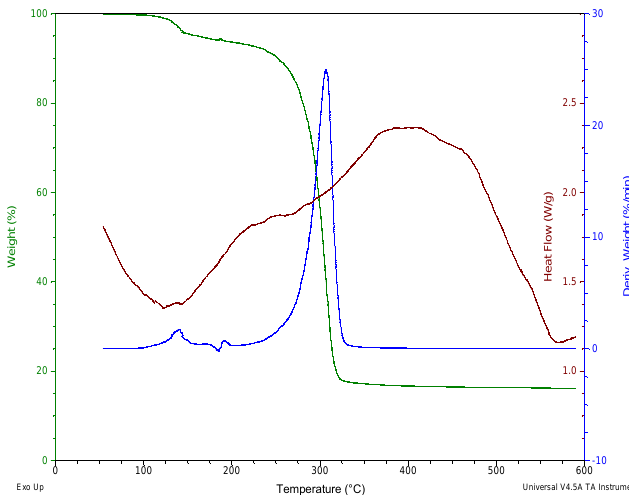
Figure 16. TG/DTG and DSC curves of diphenyltin(IV) N -methyl- N -phenyl dithiocarbamate obtained in N 2 (75 mL/min at heating rate 10 °C/min. Copied from [86] with permission from Elsevier (Copyright 2018).